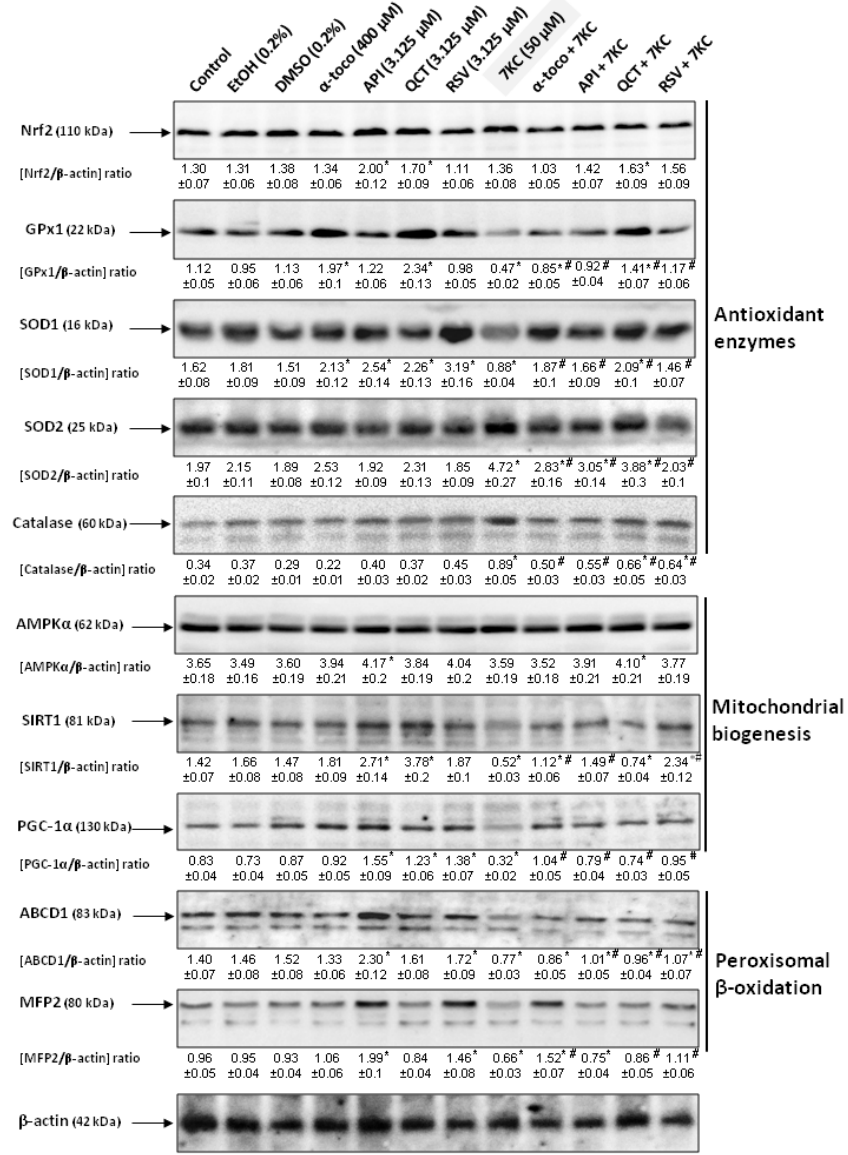
Figure 5. Effects of resveratrol, quercetin, apigenin, α -tocopherol and 7-ketocholesterol on the expression of antioxidant proteins (Nrf2, GPx1, SOD1, SOD2, catalase), mitochondrial biogenesis proteins (AMPK α , SIRT1, PGC-1 α ) and enzymes involved in the peroxisomal β -oxidation (ABCD1, MFP2) in murine N2a neuroblastoma cells. N2a cells previously cultured for 24 h were cultured for 48 h with or without 7-ketocholesterol (7KC, 50 µM) in the presence or absence of polyphenols: resveratrol (RSV), quercetin (QCT) or apigenin (API) at 3.125 µM or α -tocopherol (400 µM). Representative Western blots for analysis were presented, showing protein abundance of antioxidant protein markers (expression of nuclear factor erythroid 2-related factor 2 (Nrf2), glutathione peroxidase (GPx1), superoxide dismutase 1 (SOD1), superoxide dismutase 2 (SOD2) and catalase), mitochondrial biogenesis proteins (AMP-activated protein kinase- alpha (AMPK α ), Sirtuin 1 (SIRT1) and peroxisome proliferator-activated receptor gamma co-activator-1 alpha (PGC-1 α )) and of proteins involved in peroxisomal β -oxidation (ATP binding cassette subfamily D member 1 (ABCD1) and peroxisomal multifunctional enzyme type 2 (MFP2). β -actin was used as the loading control. The intensities of the bands for each set were individually determined and are presented as the ratio over β -actin signal. The EtOH value (0.2%) and the DMSO value (0.2%) correspond to the final EtOH and DMSO concentration in the culture